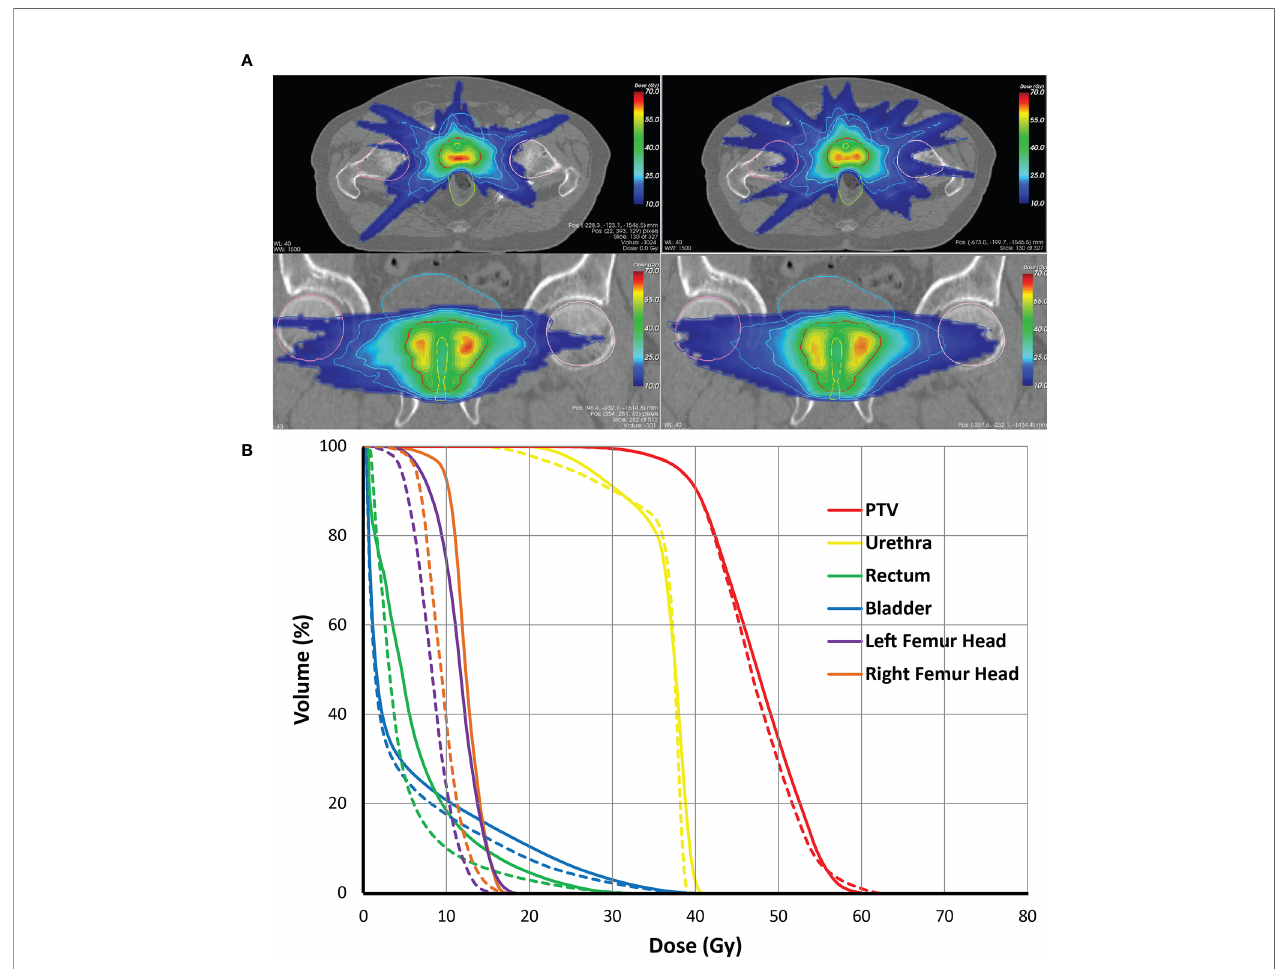
FIGURE 6 | (A) Comparison of dose distributions for the VMAT+CS (left) and VMAT plans (right) for an exemplary patient on the axial, and coronal planes, (B) Population average dose-volume histograms for the VMAT (solid lines) and the VMAT+CS (dashed lines) plans of the entire patient cohort.